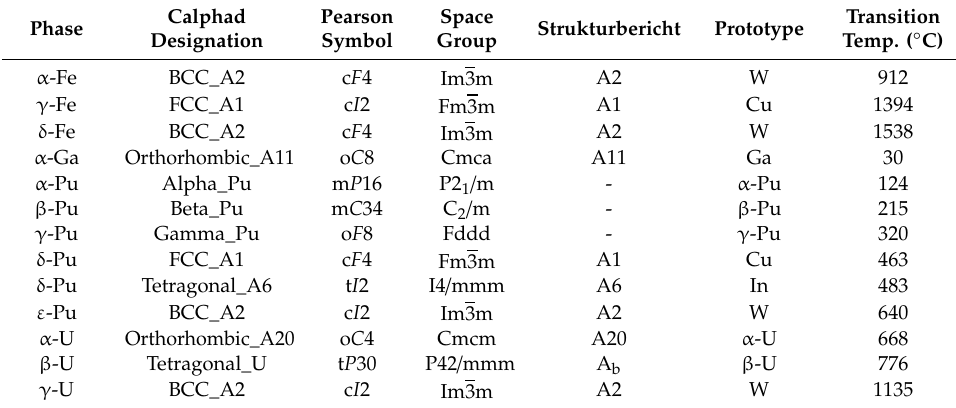
Table 1. Crystal structure of unary systems.